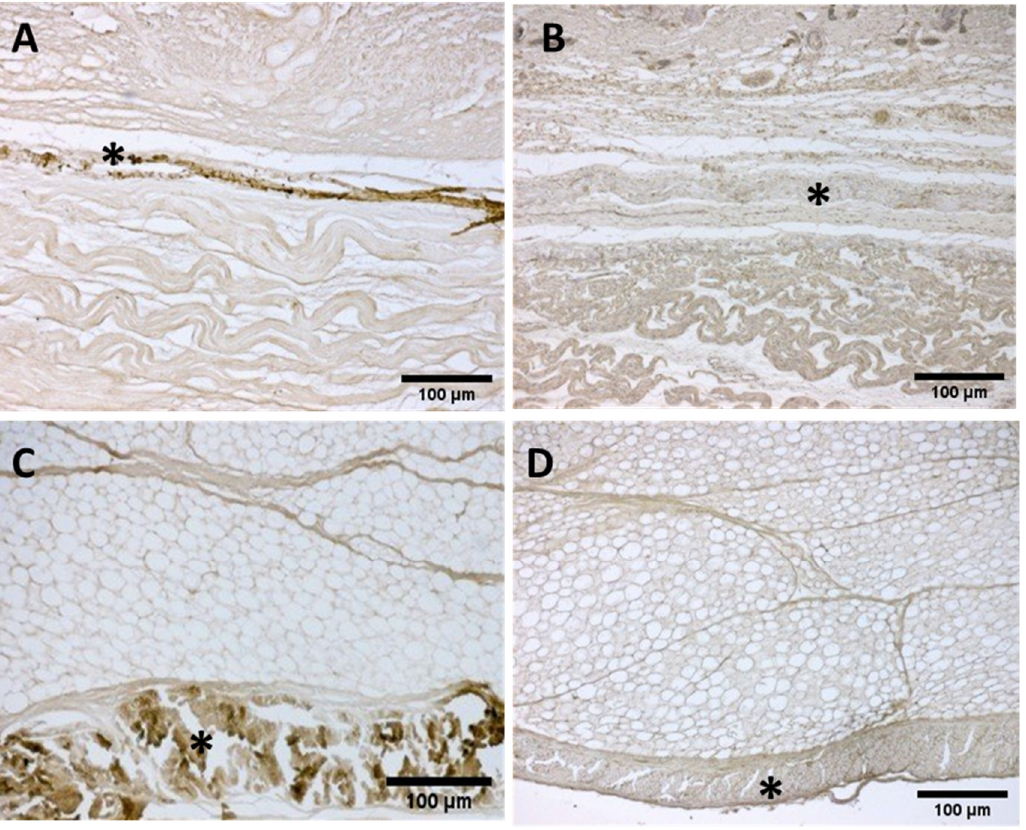
Figure 10. Immunostaining to detect Collagens I and III: Anterior deep fascia of the thigh: Collagen I ( A ) 29 weeks and ( C ) 38 weeks; Collagen III ( B ) 29 weeks and ( D ) 38 weeks. (*) deep fascia. The first part of gestation is distinguished, starting from the 29th week, by an irregular connective tissue with Col I and Col III beginning to delineate the layers ( A , B ), whilst the second part of the gestation, 38th week ( C , D ), presented with a denser connective tissue that was better organized, with Col I and Col III, which tend to increase in quantity and constitute the different fascial layers.